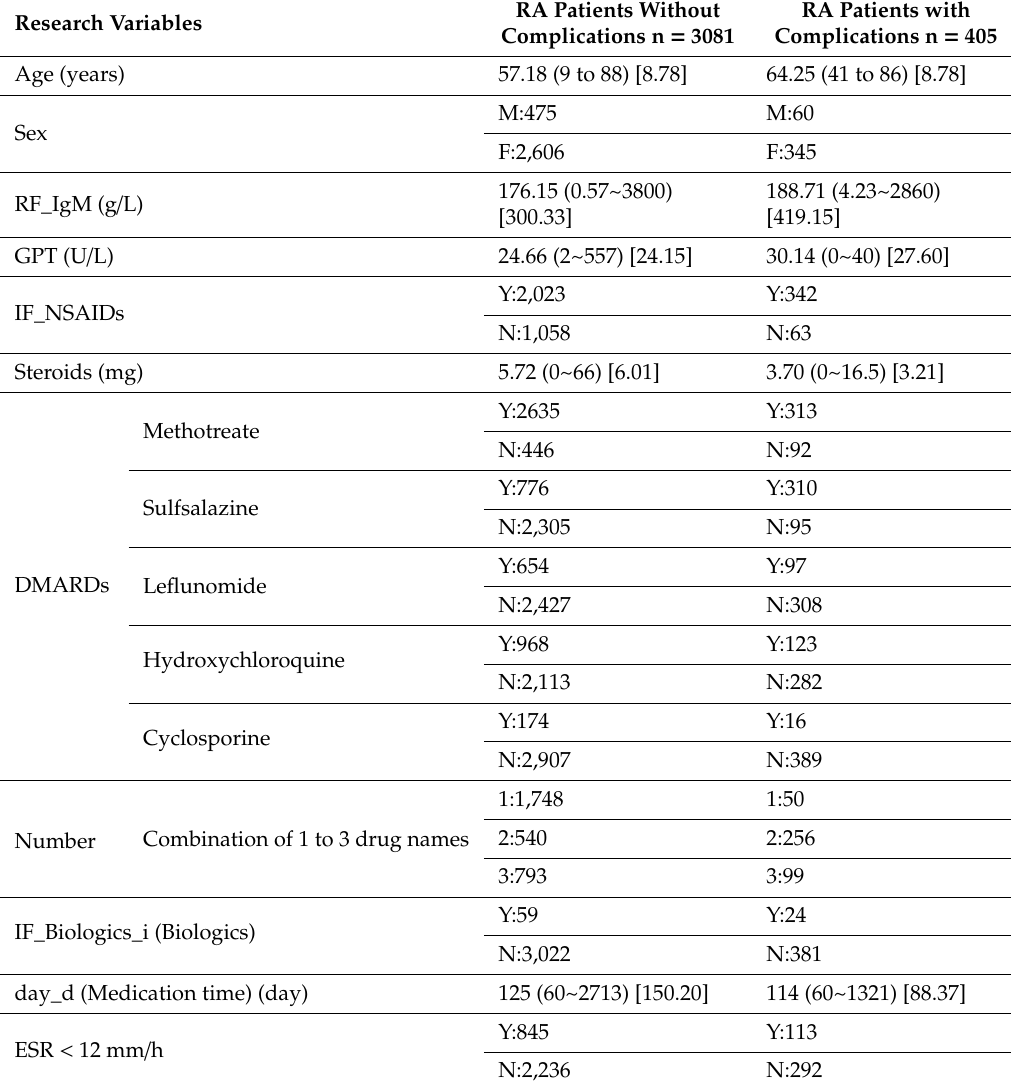
Table 2. Descriptive statistics of rheumatoid arthritis (RA) without and with complication dataset. Research Variables